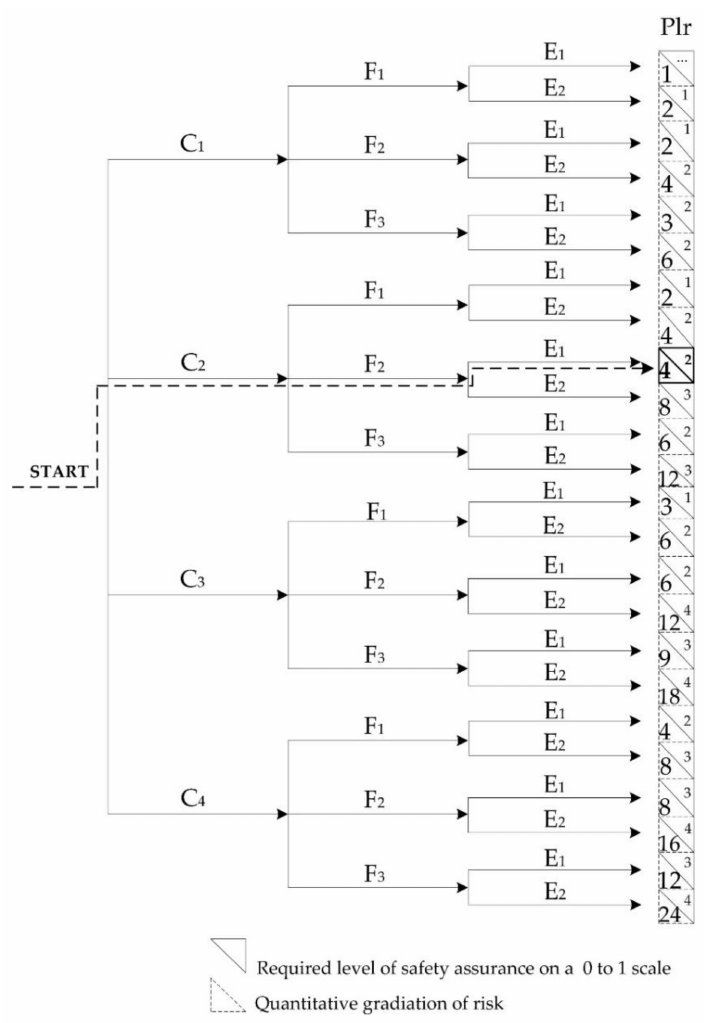
Figure 3. The determination of the PL r level for the water-supply system (WSS) examined in line with the scenario